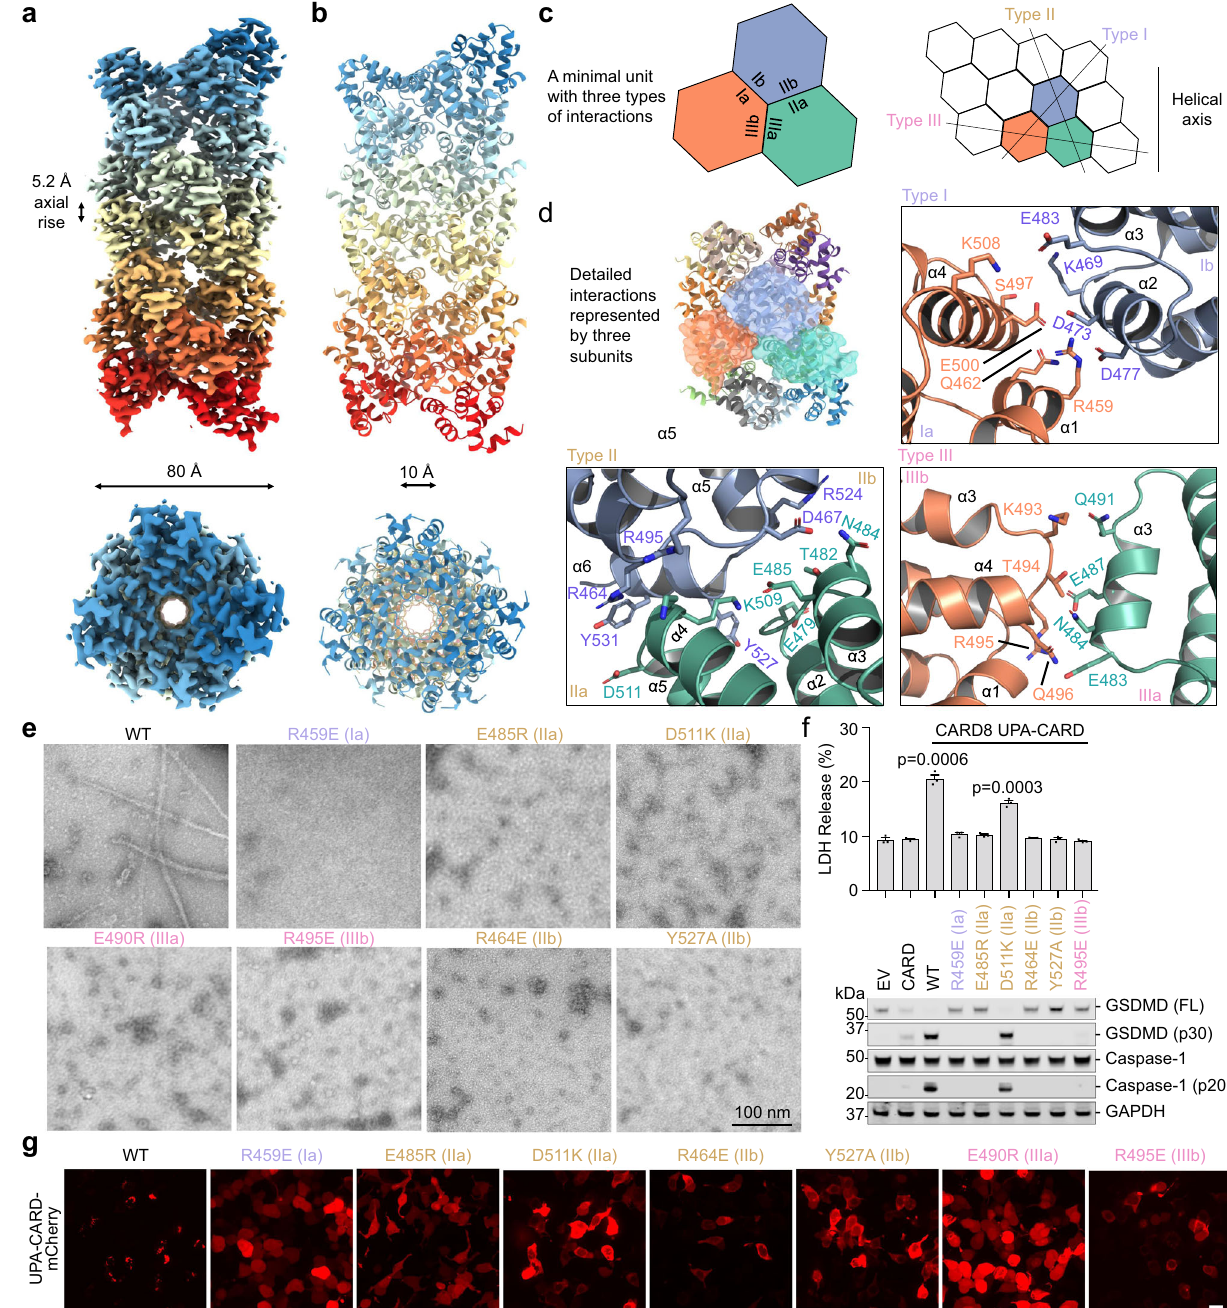
Fig. 2 Cryo-EM structure and mutagenesis of the CARD8-CT fi lament. a , b Overall structure of the CARD8-CT in fl ammasome, with a resolved CARD8 CARD fi lament. The cryo-EM density ( a ) and atomic model ( b ) are colored by subunit. c Illustration of classical CARD fi lament interfaces: type I, II, and III. d Detailed CARD – CARD interactions in the CARD8-CT fi lament structure colored as in c . e Negative stain electron microscopy snapshots of CARD8 CARD wild-type (WT) and mutants that abolish fi lament formation in vitro. Filaments were formed at 15 µ M (shown here) and 30 µ M. Micrographs are representative of >3 fi elds of view for each sample. f In fl ammasome assay of CARD8-CT-mCherry mutants transiently expressed in HEK293T cells that stably express caspase-1 and GSDMD. Filament-de fi cient mutants abolish in fl ammasome activity as measured by LDH release (top) and western blot (bottom) for activated in fl ammasome components. P -values are compared to empty vector (EV) by two-sided Student ’ s t -test. Exact P -values are provided in the Source Data File. Data are means ± SEM of n = 3 biological replicates. g Confocal imaging of HEK293T cells transiently expressing CARD8 UPA-CARD - mCherry WT and mutants. Filament-de fi cient mutants abolish fi lament formation in cells. Experiments were performed with two biological replicates. Scale bar 5 µ m. In e – g , mutations are labeled in the colors of the interface types as de fi ned in c